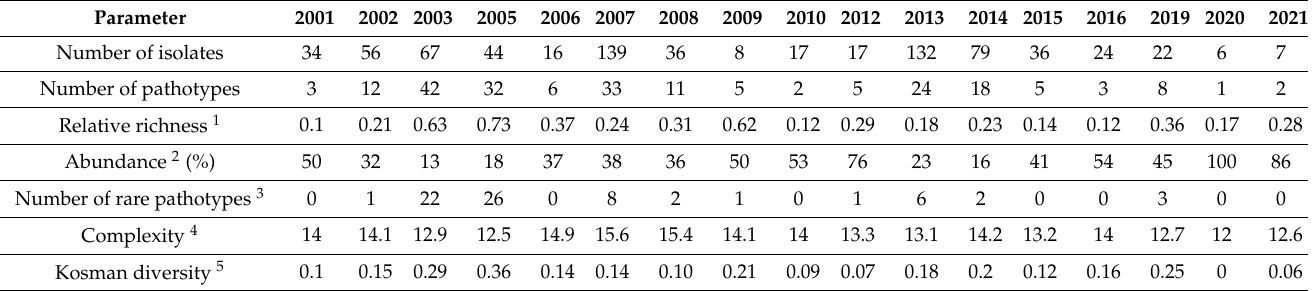
Table 2. Descriptive parameters of northwestern population of Puccinia triticina in